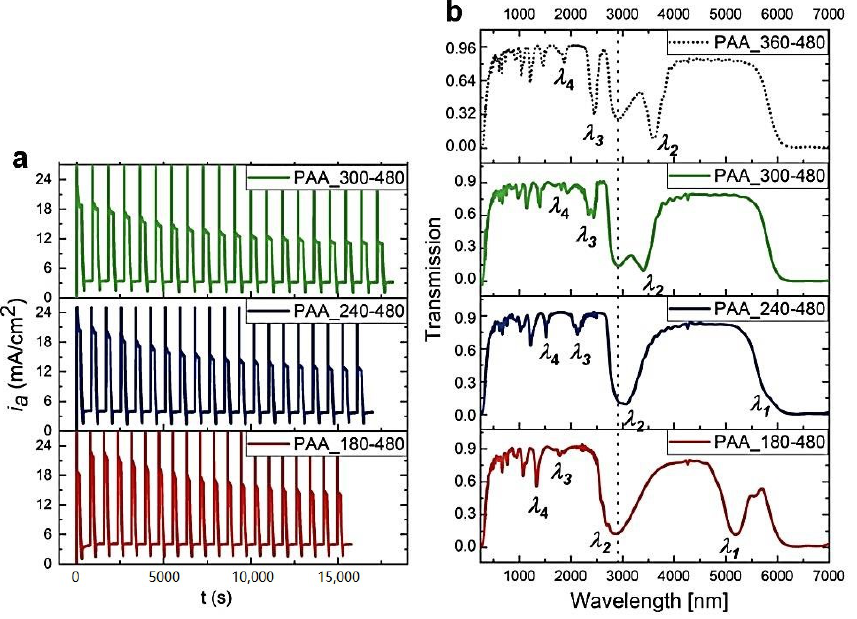
Figure 7. The i a ( t ) curves recorded during pulse anodization at 30 ◦ C, under U H of di ff erent t H [s] (PAA_t H -t L , other parameters: U H = 50 V, U L = 20 V, U H - > U L rate = 0.234 V / s, 20 cycles) ( a ) and the corresponding transmission spectra (the transmission spectra for the PAA_360-480 is taken from [27] for comparison) ( b ).